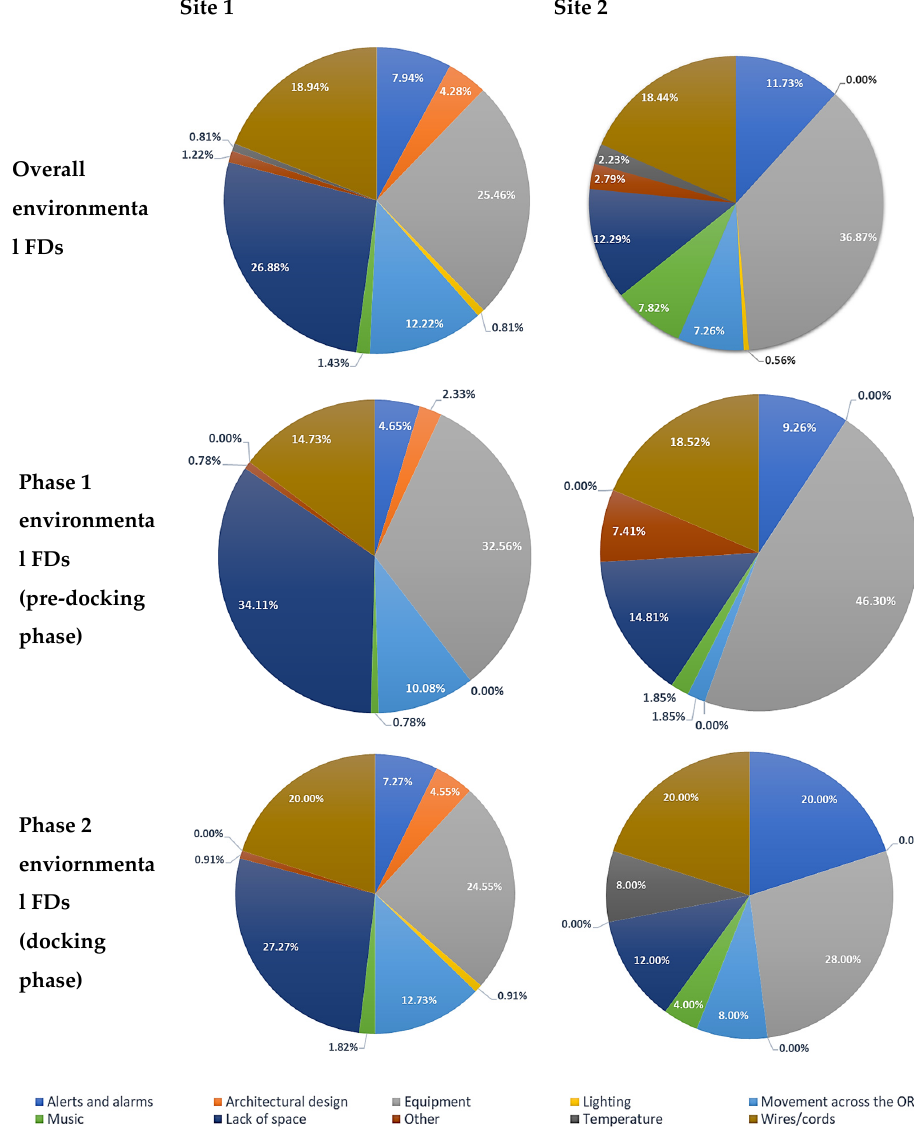
Figure 4. Percentage of environmental FDs at site 1 and site 2.